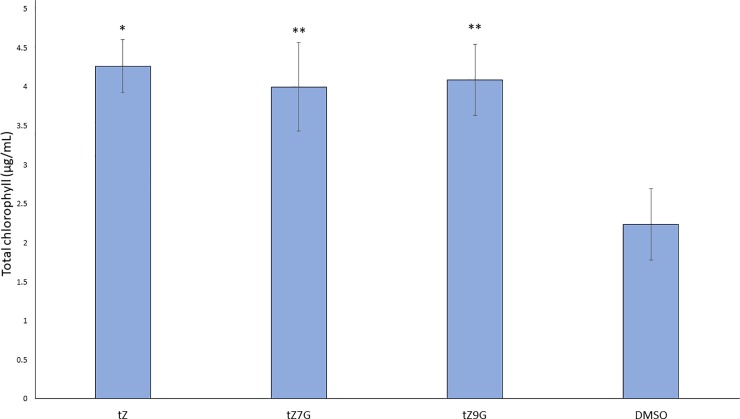
trans-Zeatin-N-glucosides delay chlorophyll degradation in detached cotyledons.Cotyledons from 12dag WT Arabidopsis seedlings were excised and floated abaxial side down in 3mM MES buffer (pH 5.7) supplemented with 1μM of the indicated hormone or 0.1% DMSO as a control. Solutions were placed in the dark for six days, after which chlorophyll was extracted and quantified according to Sumanta et al., 2014. Average ± SE of three biological replicates is presented. * p-value < 0.05, ** p-value < 0.01, paired two-tailed Student’s t test.